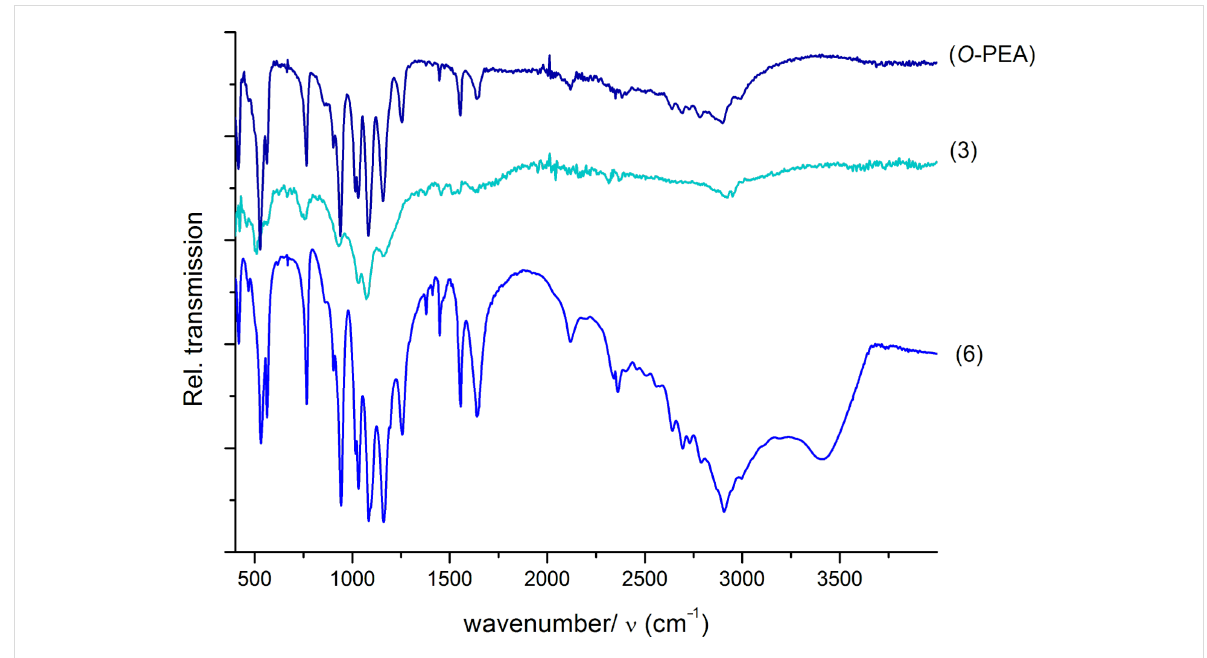
Figure 2: ATR-FTIR spectra of species 3 and 6 from Scheme 1 in comparison to O -phosphorylethanolamine ( O- PEA).